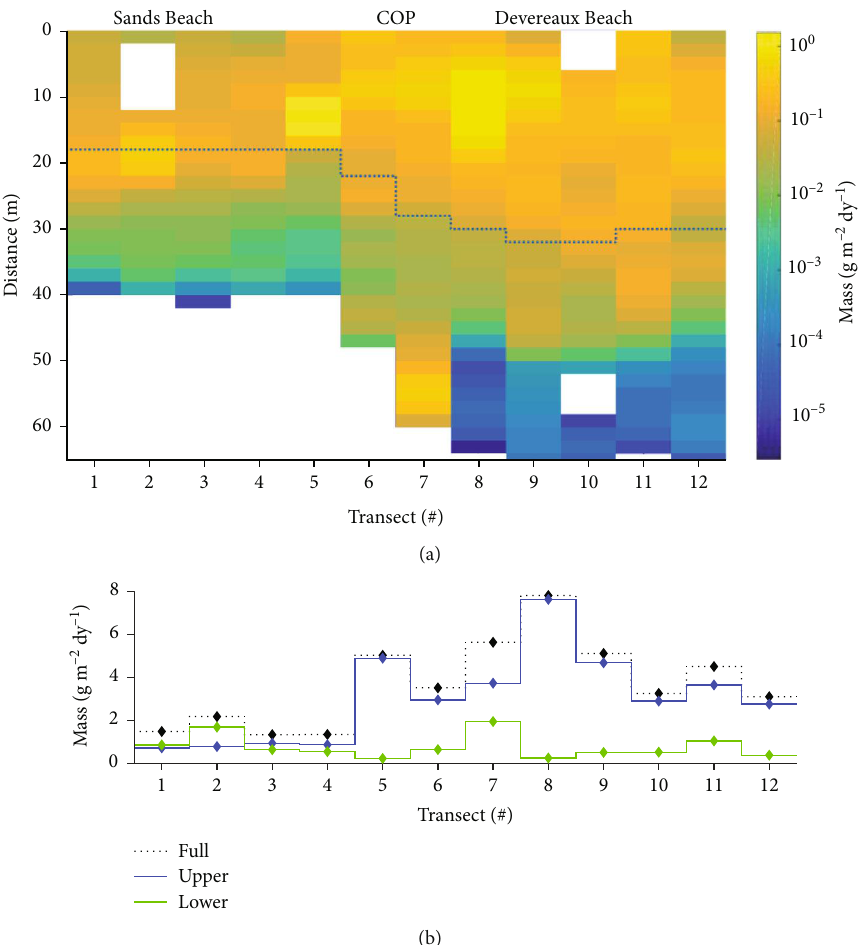
Figure 31: (a) Daily mean tar mass, 2007-2009, for Coal Oil Point (COP), versus distance from the blu ff s and transect. Tar mass was 4m smoothed along the distance axis. Dotted line shows midbeach point. (b) Aggregated tar mass, integrated along the distance axis for the full beach and upper and lower